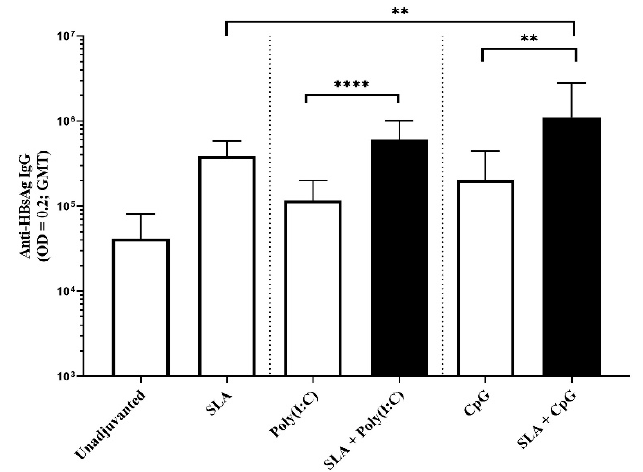
Figure 5. HBsAg-specific antibody titers in mice. Mice were immunized with HBsAg antigen alone or formulated with SLA archaeosomes, other adjuvants ((Poly(I:C) and CpG) or SLA in combination with other adjuvants on days 0 and 21. On day 28 (7 days post-2nd immunization) serum was collected and levels of antigen-specific IgG antibodies measured by ELISA. Grouped data are presented as geometric mean titer + 95% confidence interval ( n = 5/group). ** represents p < 0.01 and **** represents p < 0.0001.